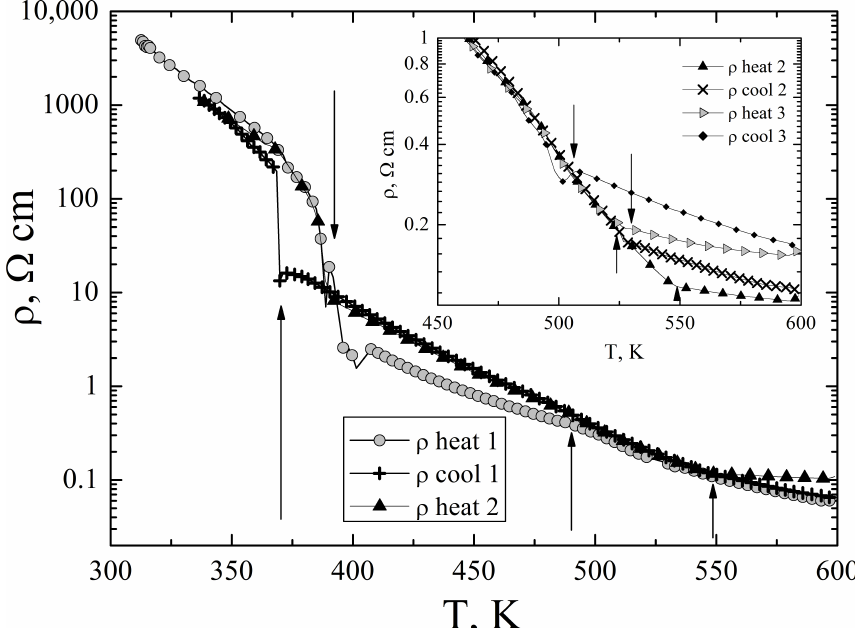
Figure 4. Electrical resistivity of Ag 3 CuS 2 . The arrows indicate temperatures at which the resistivity has peculiarities, these temperatures well correlate with the structural phase transitions according to Ref. [11]. The inset shows the evolution of the peculiarity near to 500 K with thermal cycling. The upward pointing arrows indicate the on-heating temperature of the transition, while the downward pointing arrows show the on-cooling transition temperature according to the resistivity